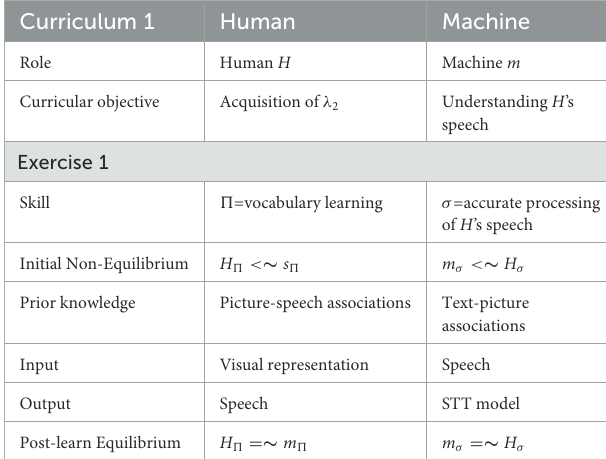
TABLE 1 Structure of the first exercise of HMPL − C 1 . See Section 2.1 for a closer description of the employed